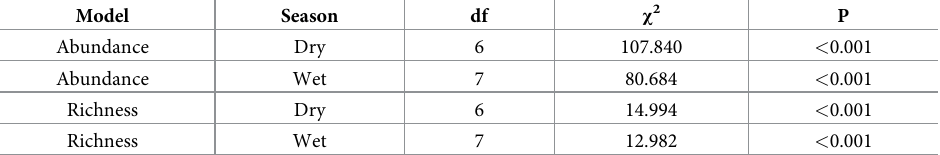
Table 2. Generalized linear model outputs showing the significant differences in herbivore species richness and abundance across configurations in both the wet and dry